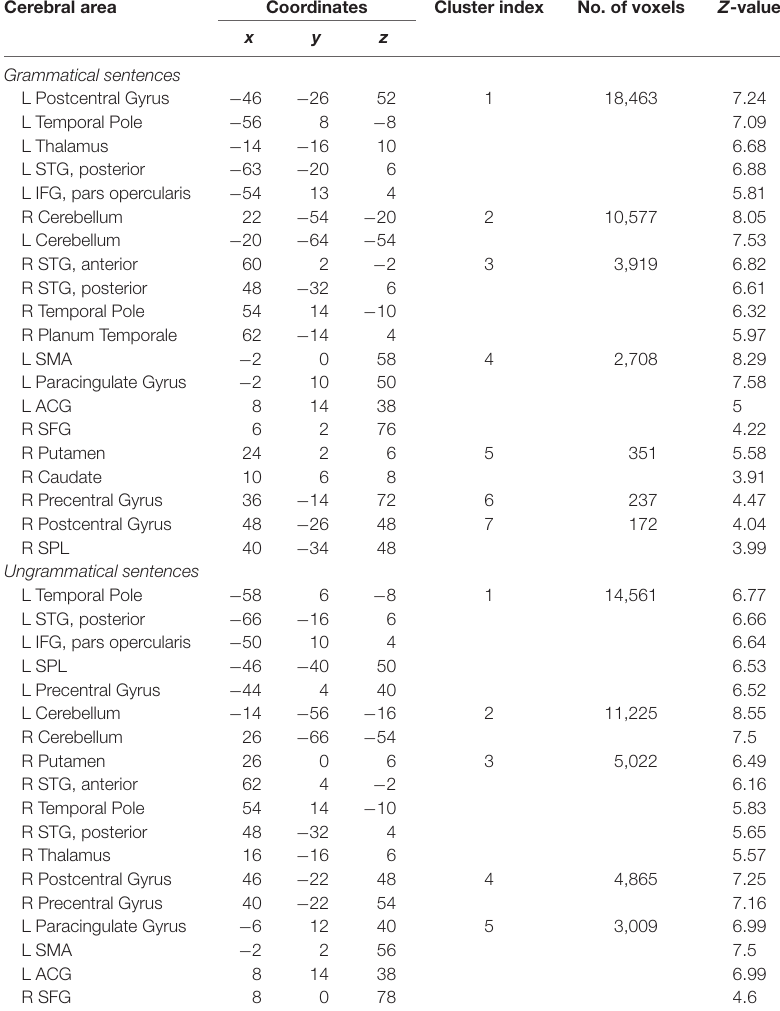
TABLE 2 | Brain regions involved in L1 separately for each condition compared to the baseline (whole-brain analyses). Cerebral area